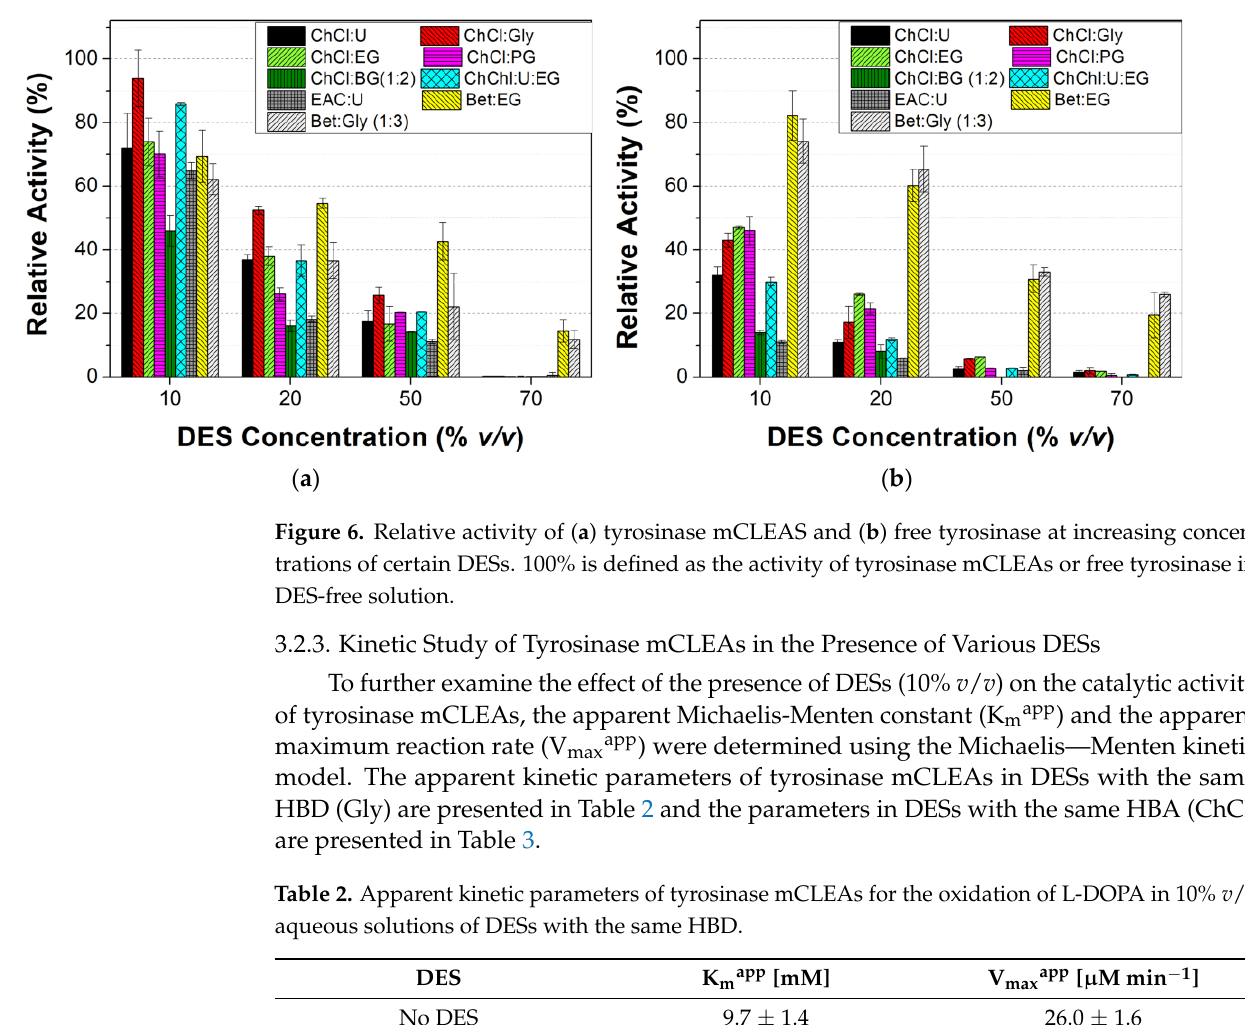
Table 3. Apparent kinetic parameters of tyrosinase mCLEAs for the oxidation of L-DOPA in 10% v / v aqueous solutions of DESs with the same